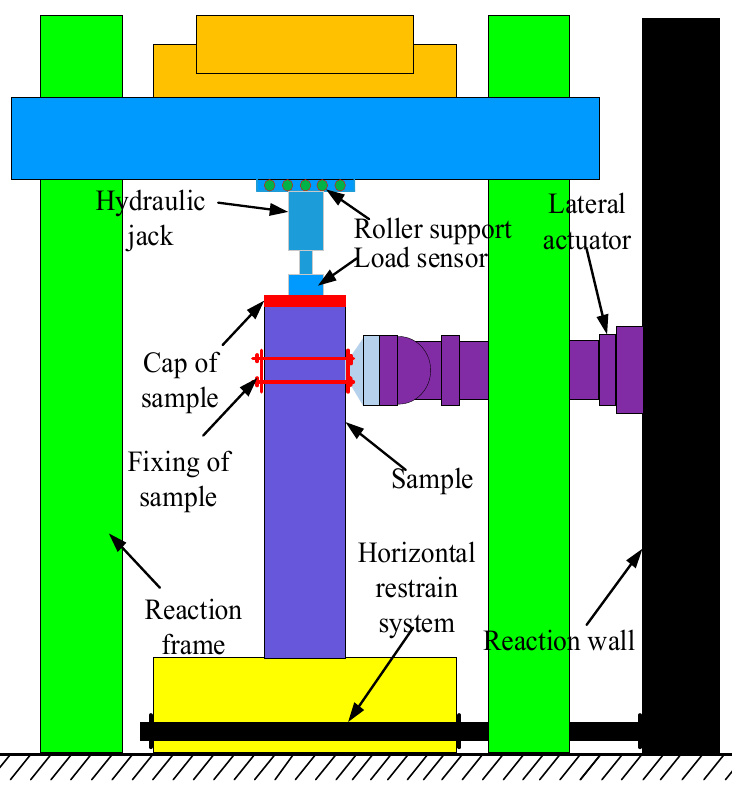
Figure 3. Testing stet-up for load process schematic diagram of testing arrangement.